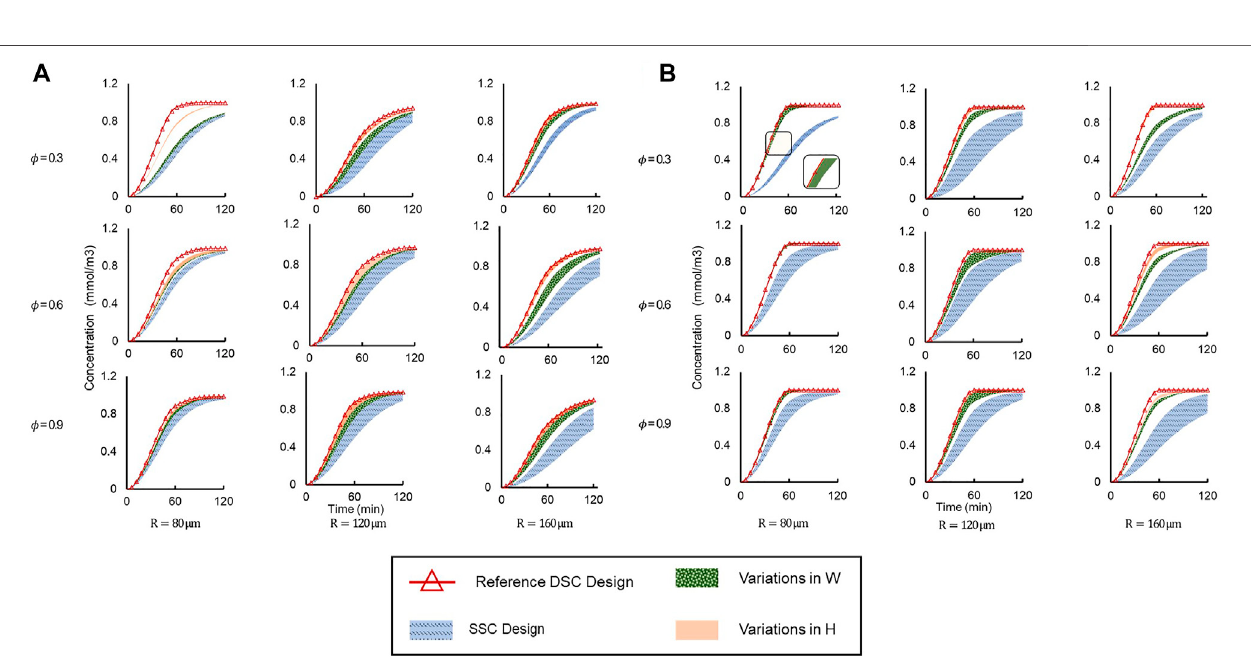
FIGURE 7 | Concentration vs time pro fi les simulated at the spheroid core up to t (cid:2) 120 min under different geometric conditions and spheroid porosities ( φ ) for (A) Q 1 (cid:2) Q 2 and (B) Q 1 (cid:2) 2 × Q 2 . Legend: “ SSC Design ”— entire range ofSSC designs; “ Reference DSC Design ”— H R (cid:2) H L (cid:2) W R (cid:2) W L (cid:2) 60 μ m; “ Variations in H ”— W R (cid:2) W L (cid:2) 60 μ m are constant and H varies independently; “ Variations in W ”— H R (cid:2) H L (cid:2) 60 μ m are constant and W varies independently.